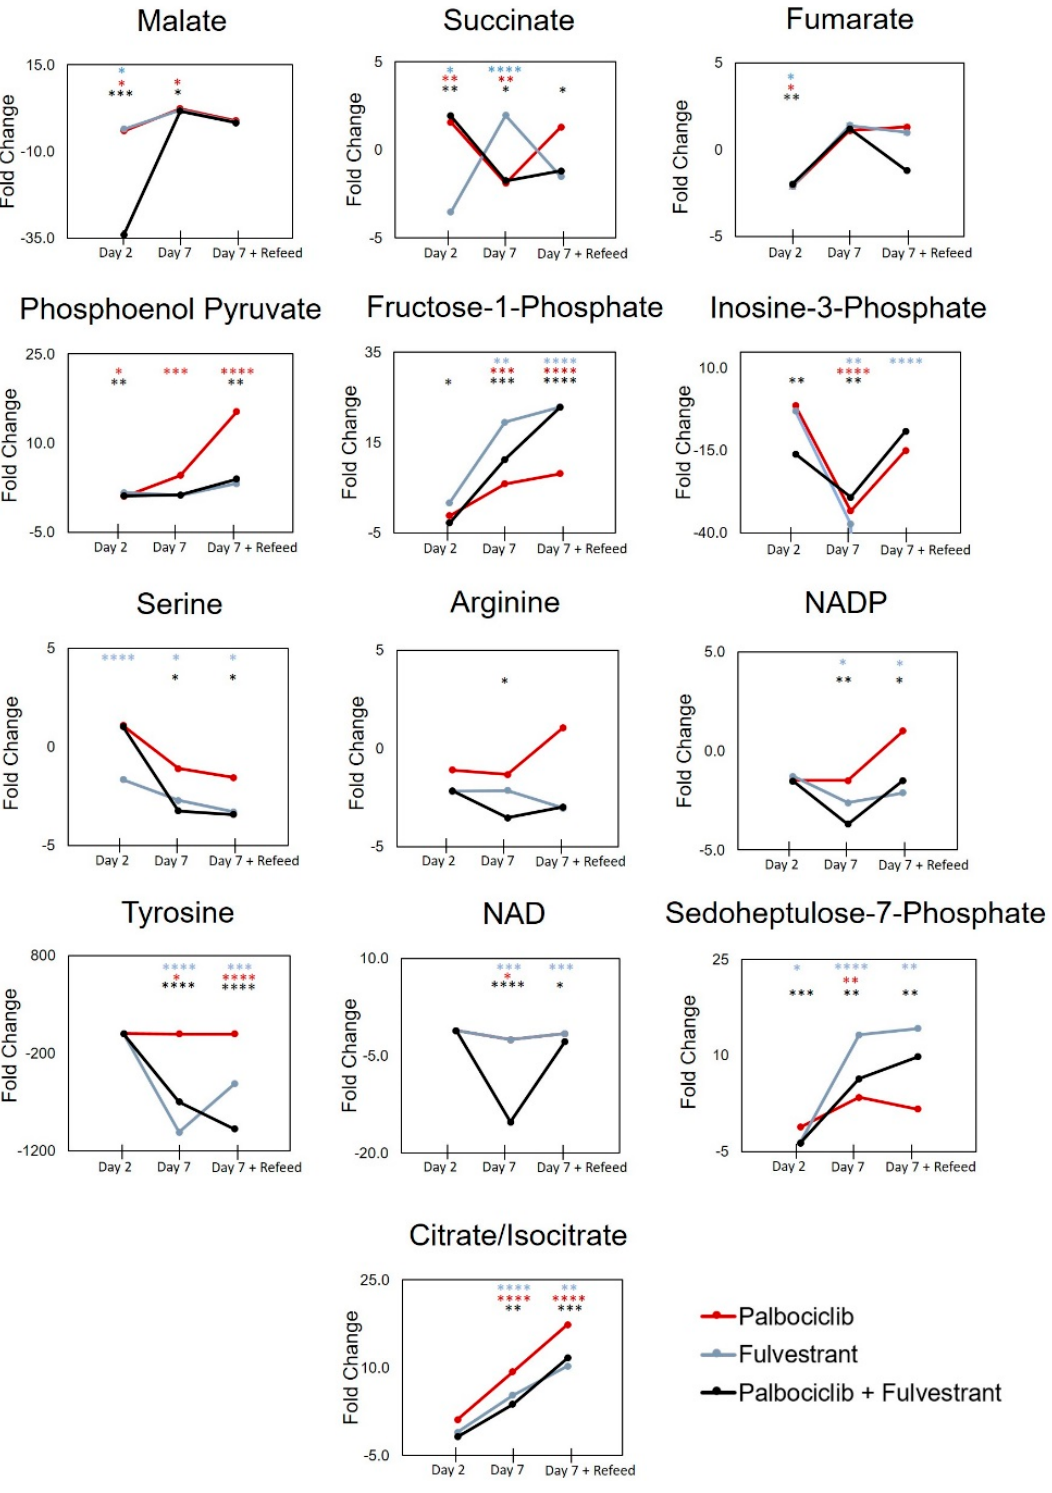
Figure 4. Fold change in metabolites in MCF-7 breast cancer cells over two, seven and seven days with refeeding, post palbociclib and fulvestrant, single and combination dosing compared to control. p -value statistical significance noted on graphs * < 0.05, ** < 0.01, *** < 0.001, **** < 0.0001.